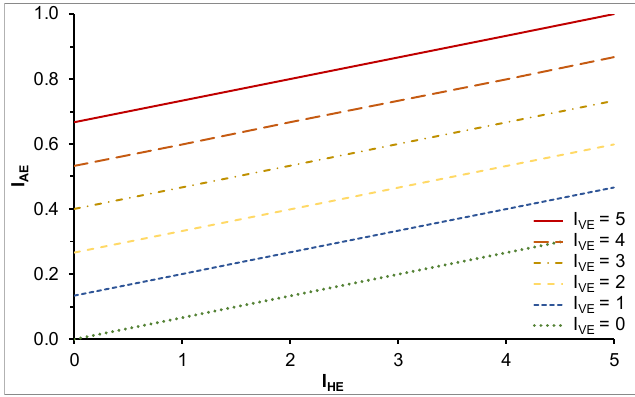
α α= = 2 α ). Figure 1. Seismic index of attention I HE VE HE